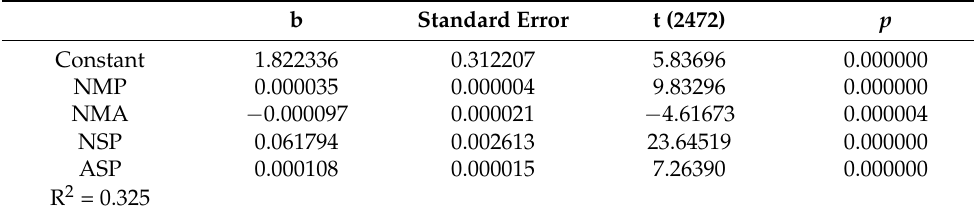
Table 3. Estimation of linear regression model parameters for the entire study sample (N = 2477).